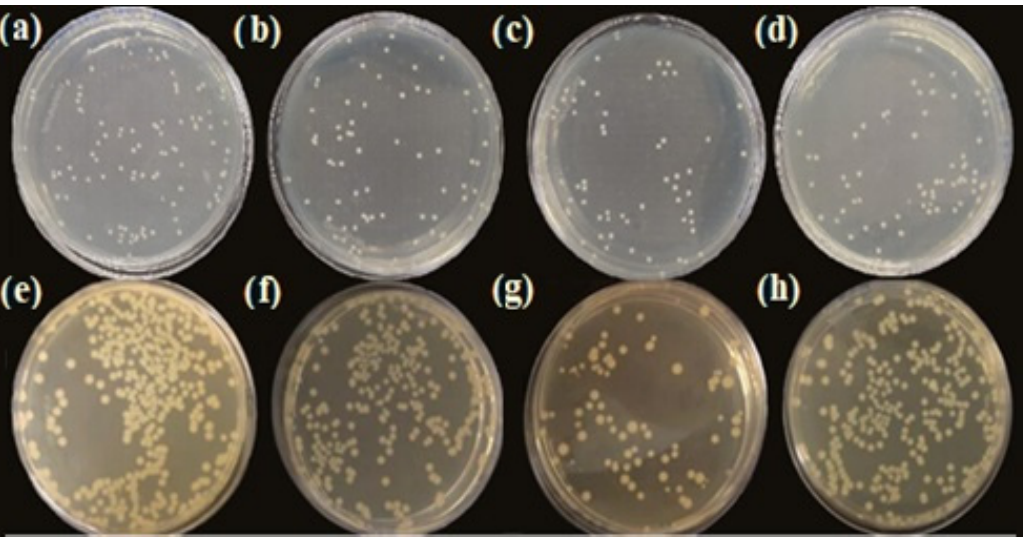
Figure 6. Images of microbiological tests: ( a ) Staphylococcus aureus (SA) control, ( b ) inhibitory effect of BCP-60 against SA, ( c ) inhibitory effect of BCP-50 against SA, ( d ) BCP-40 inhibitory effect against SA, ( e ) Escherichia coli (EC) control, ( f ) BCP-60 inhibitory effect against EC, ( g ) BCP-50 inhibitory effect against EC, ( h ) BCP-40 inhibitory effect against EC.